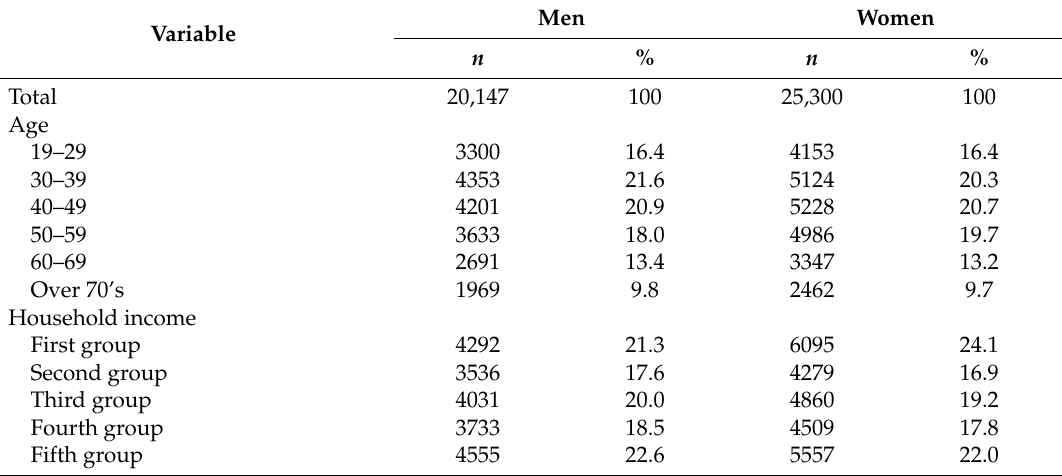
Table 1. Descriptive characteristics of study sample and obesity